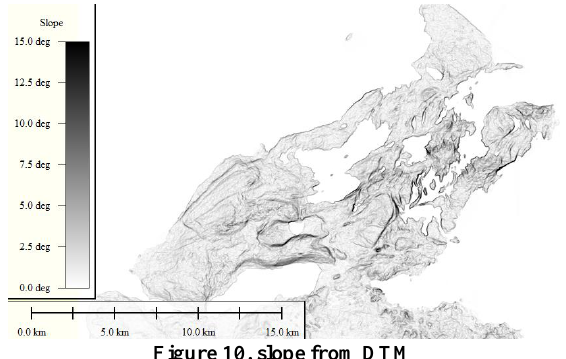
Figure 10. slope from DTM After the slope is obtained, then Aspect / Slope direction can be made. This direction of slope direction ranges from 0-360 0 . Slope direction is in Figure 11.